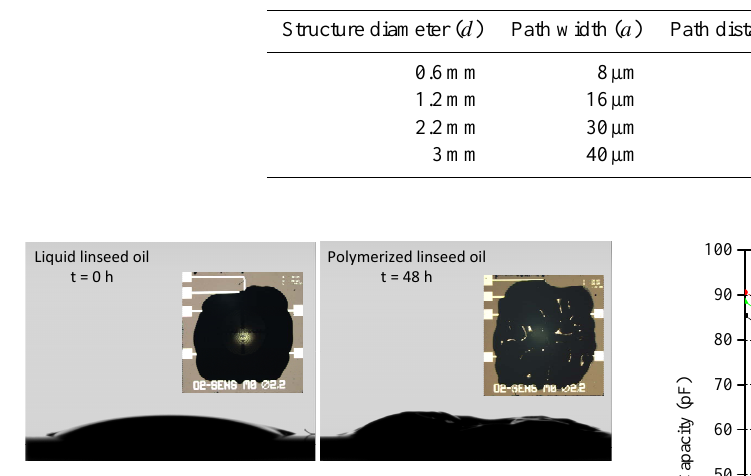
Figure 5. Sensor (structure diameter d = 2.2mm) with liquid linseed oil (left) at the beginning and after polymerisation to linoxyn (right).